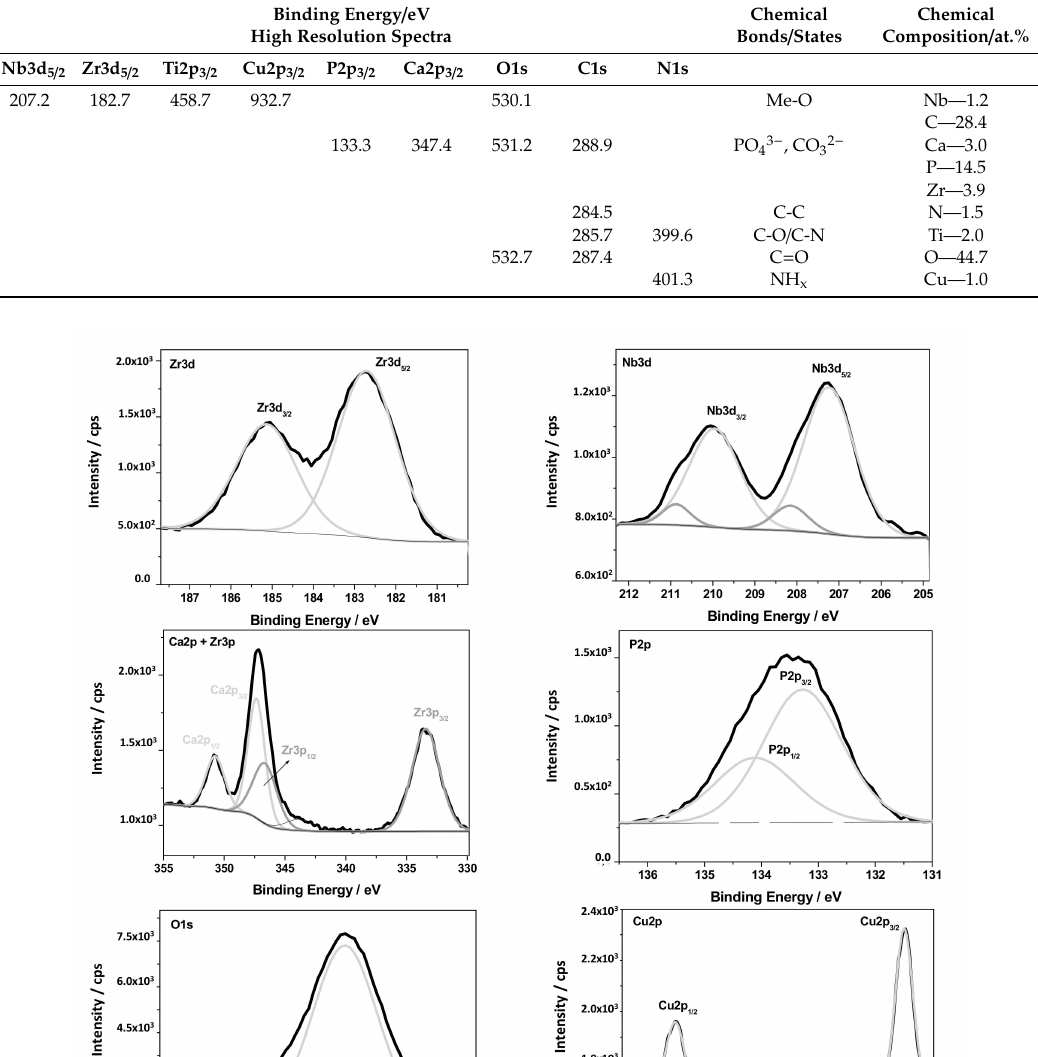
Table 2. The XPS data evaluated from the deconvolution of Nb3d, Zr3d, Ti2p, Cu2p, P2p, Ca2p, O1s, C1s, and N1s XPS spectra recorded for the ZrNb-500 sample.